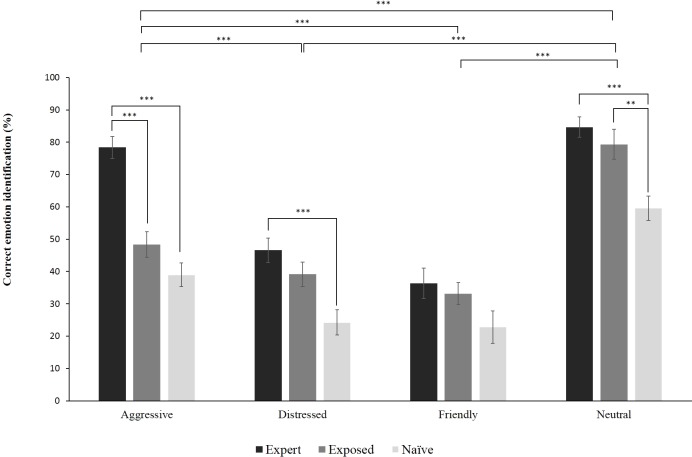
Bar graph representing the percentage of correct identification scores of Barbary macaques’ emotional state by experience and emotional states.*** p = 0.01, ** P < 0.01, * P < 0.05. Error bars represent ±1 standard error of the mean.